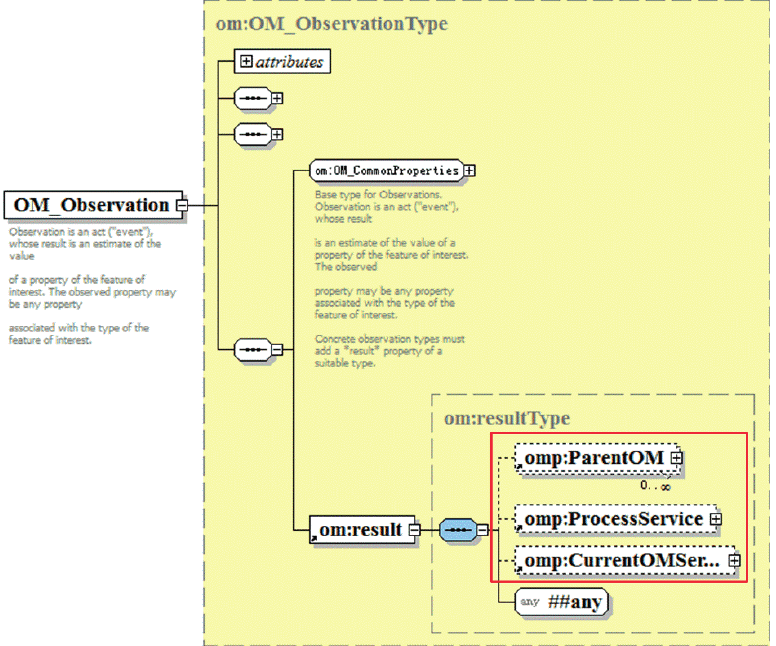
Figure 5. ( a ) ProcessService and ( b ) CurrentOMService Schemas.